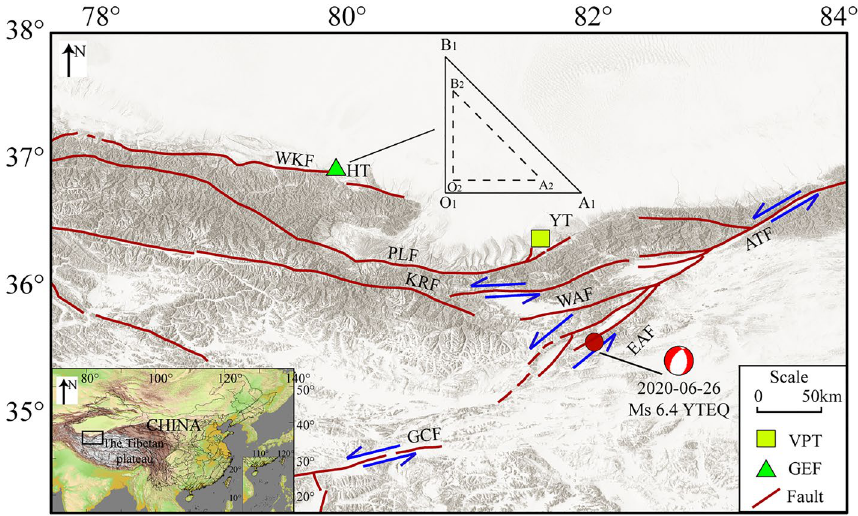
Figure 2. Main faults and geophysical observatories near the M s 6.4 Yutian earthquake that occurred in 2020. Red lines indicate faults, including West Kunlun fault (WKF), Pulu fault (PLF), Karakax fault (KRF), Altun Tagh fault (ATF), west branch of Ashikule fault (WAF), east branch of Ashikule fault (EAF) and GozhaCo fault (GCF). Blue arrows indicate the relative motion of some faults. The focal mechanism represents the Yutian (YTEQ) earthquake. Square is locations of vertical pendulum tilt (VPT) in Yutian (YT) station. Triangle is locations of geo-electric field (GEF) in Hotan (HT) station. Top middle: the schematic damage of the